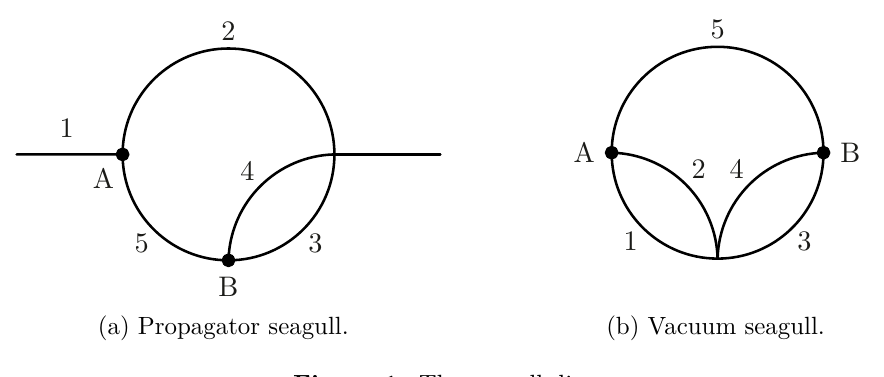
Figure 1. The seagull